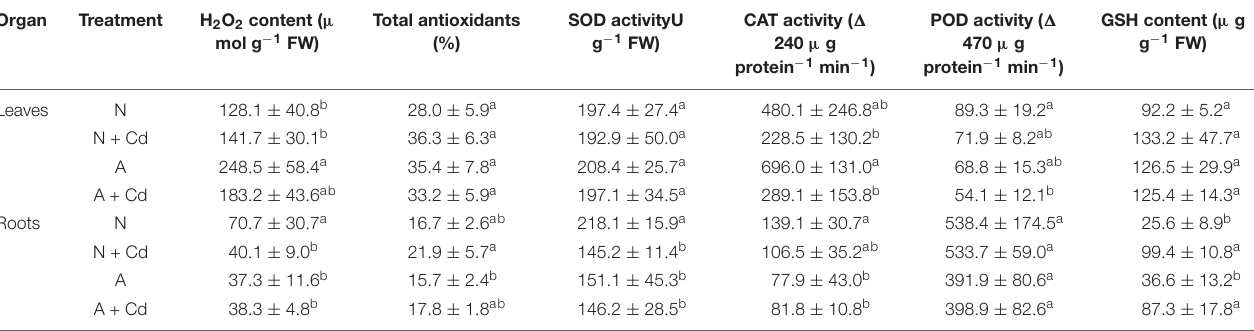
FIGURE 5 | Maximum efficiency of the PSII (Fv/Fm), photochemical quantum yield (QY), non-photochemical quenching (NPQ) and photochemical quenching (qP) in leaves of sweet sorghum as affected by nitrate and ammonium in the presence or absence of Cd under unbuffered (A) or buffered (B) pH condition. N, nitrate; N + Cd, nitrate with Cd; A, ammonium; A + Cd, ammonium with Cd. Different letters above the bars represented significant differences at the level of 0.05 based on One-Way ANOVA and Duncan’s multiply analysis. TABLE 2 | Effects of nitrate and ammonium on antioxidant defense systems in leaves and roots of sweet sorghum with or with Cd stress under unbuffered pH condition. Organ